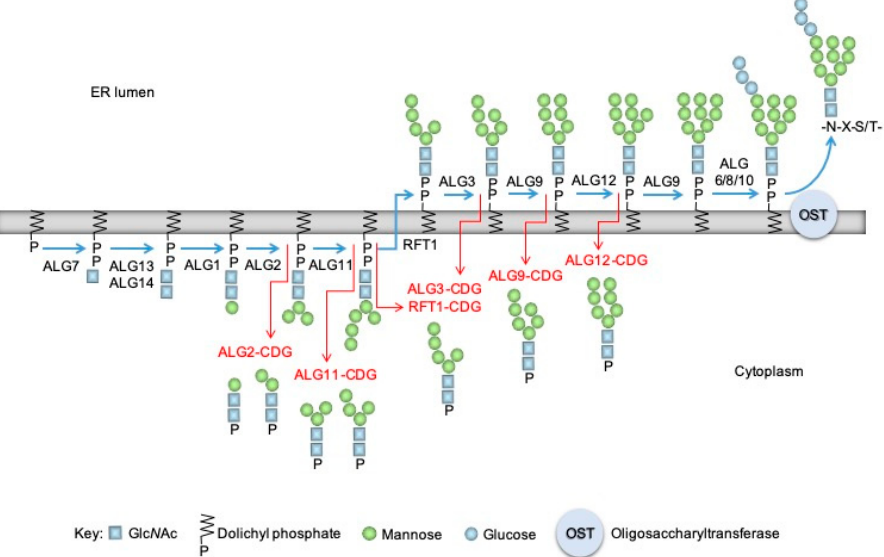
Figure 1. The dolichol cycle, N -glycan biosynthesis, and the production of oligosaccharylphosphates in congenital disorders of glycosylation. Dolichyl phosphate (left) is glycosylated on the cytoplasmic face of the ER to yield Man 5 GlcNAc 2 -PP-dolichol which is flipped into the ER and further elongated to yield mature Glc 3 Man 9 GlcNAc 2 -PP-dolichol (DLO; blue arrows). Gene names of the proteins required for some of the major steps are indicated next to the blue arrows. Oligosaccharyltransferase (OST) transfers the oligosaccharide of mature DLO onto nascent polypeptides (N-X-S/T). In some congenital disorders of glycosylation where genes of the dolichol cycle are mutated, increased amounts of cytoplasmic oligosaccharyl phosphates (OSP), indicated by red arrows, are detected. By way of example, in ALG12-CDG [7] the Alg12p mannosyltransferase that adds the eighth mannose residue to the growing DLO is defective, and both a truncated DLO and an OSP containing seven residues of mannose accumulate [8]. Furthermore, and not shown here, in both PMM2-CDG, in which phosphomannomutase encoded by the PMM2 gene is deficient, and glucose starvation, nucleotide sugars required by glycosyltransferases of the dolichol cycle are limiting, and truncated DLO and the corresponding OSP are observed [8–10].